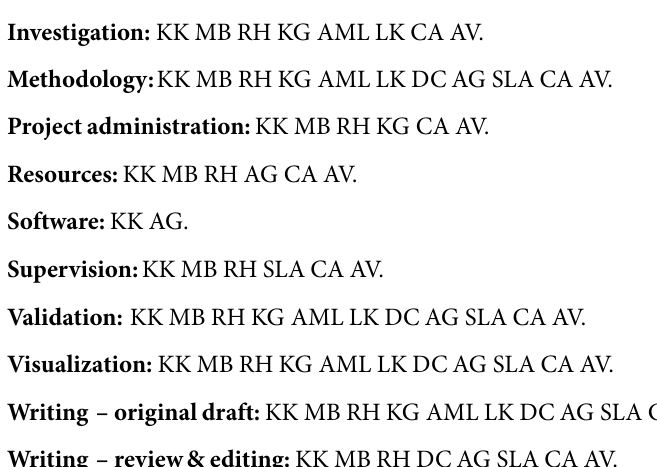
S1 Table. Putative chemicalentities changed significantlyin abundance following treat- ment with standard PDF vs . PDF with 8 mM AlaGln. Monoisotopic masses, calculated and observed,their Chemspider IDs, HMDB IDs and KEGG IDs as queried from the databases and the (putative) chemical entities. a Up-and down-regulation was defined either as significant dif- ference at time point 4 h, or in the correlation with time, or as qualitative difference with vs . without AlaGln (see Methods for details). S2 Table. Summary of adverse events. AE = Adverse Event; Calculations are based on the total number of AEs (N = 42). One mild AE (mild diarrhea) could not be assigned to treatment A or B since it persisted during both study